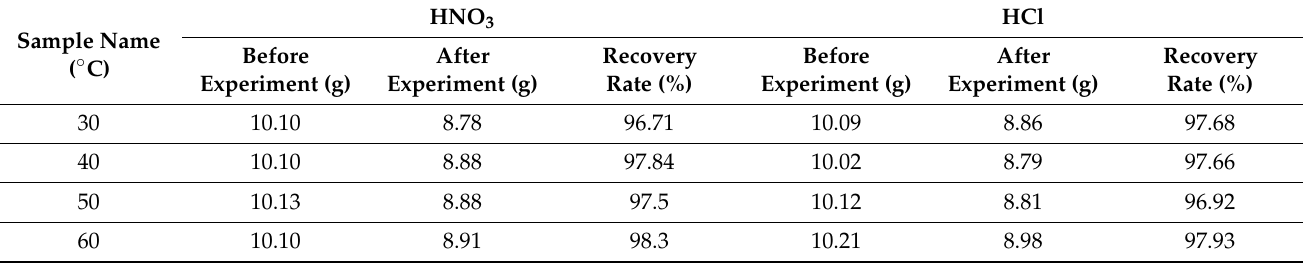
Table 6. Weight of the photovoltaic cell before and after experiment and Si recovery rates—